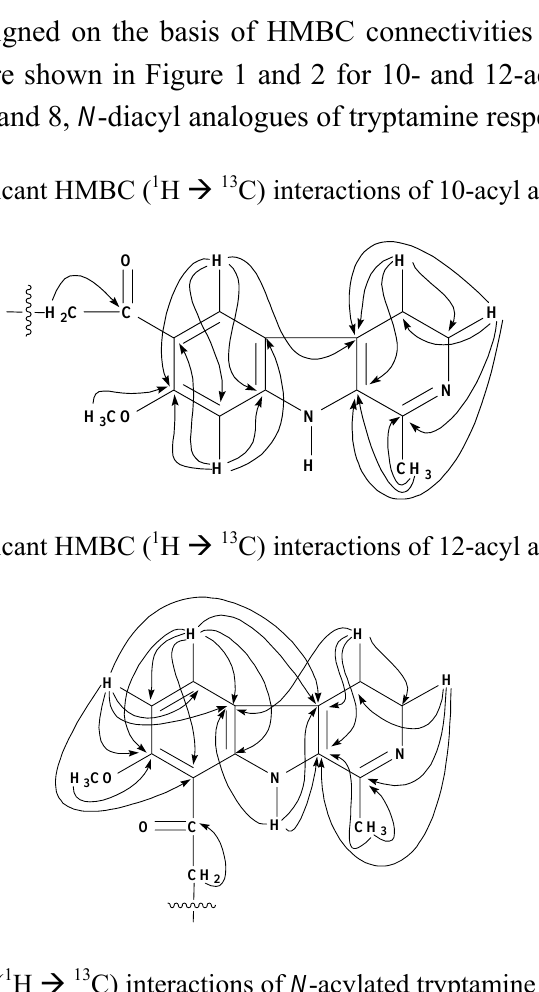
Figure 3. Significant HMBC ( 1 H (cid:198) 13 C) interactions of N -acylated tryptamine analogues obtained from 1 .